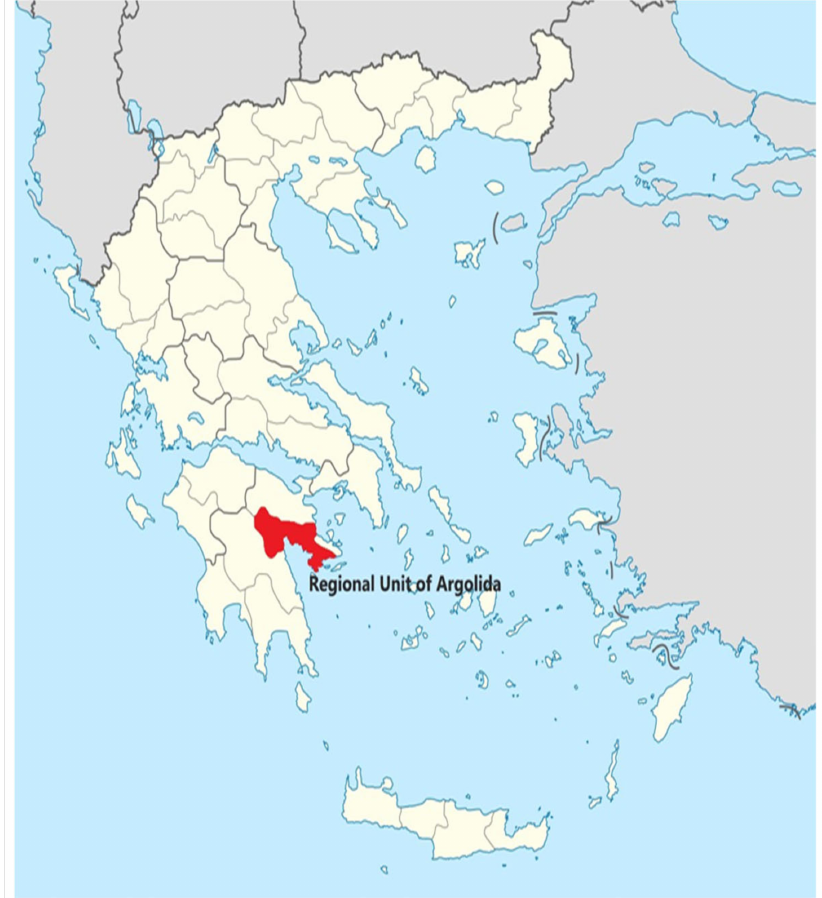
Figure 1. Map of region of Argolida. Adapted from https://en.m.wikipedia.org/wiki/File:Greece_ location_map.svg, (accessed on 7 February